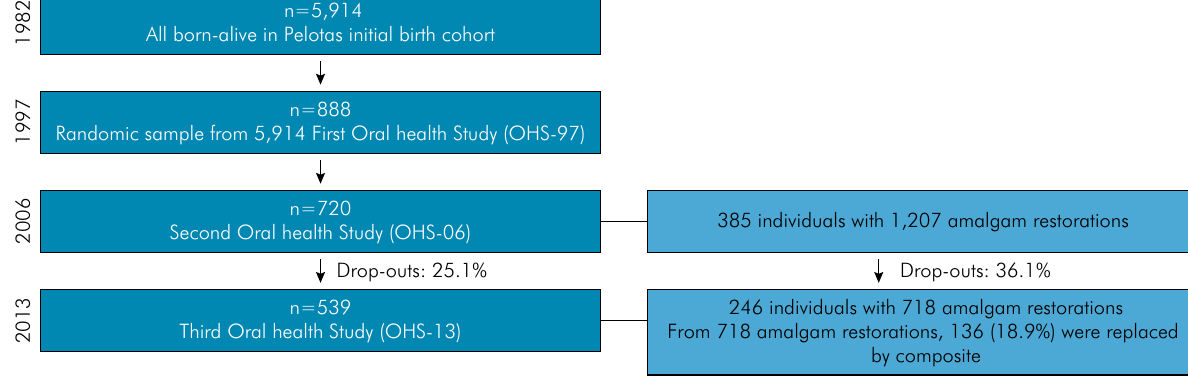
Figure 2. Flow diagram of cohort